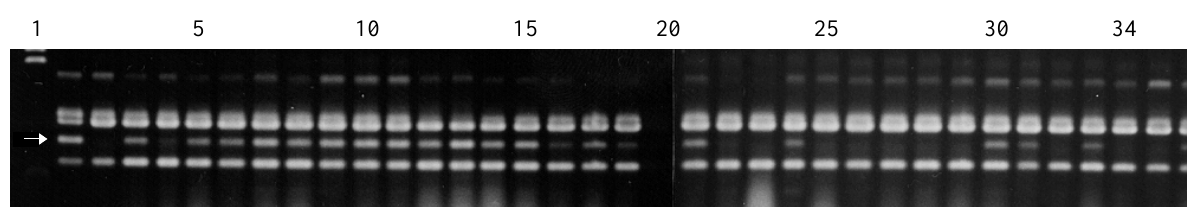
Figure 1 - RAPD pattern produced by primer OPC08 in the parents and components of resistant and susceptible bulks. The band indicated by the arrow is linked to the Co.4 allele. The band pattern of the Carioca 300V parent (lane 2), P45 parent (lane 3), resistant DNA pool (lanes 4 and 20), susceptible DNA pool (lanes 5 and 21), homozygous resistant plants (lanes 6-19) and homozygous susceptible plants (lanes 22-34) are shown. Lane 1, DNA size markers (Lambda- Hin